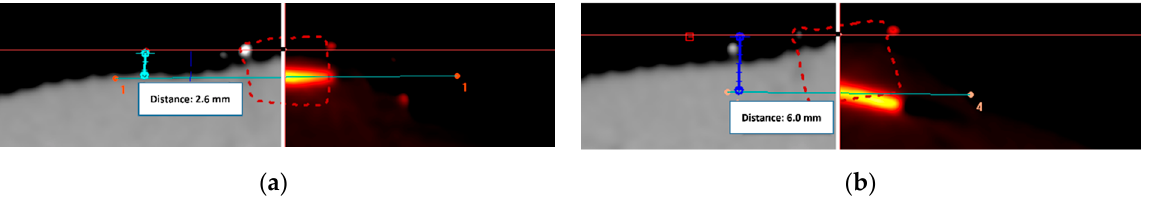
Figure 6. Pre- and post-implant phantom CT fusion, showing the first ( a ) seed insertion plane at 0.26 cm from the surface and the second ( b ) insertion plane at 0.6 cm from the surface.